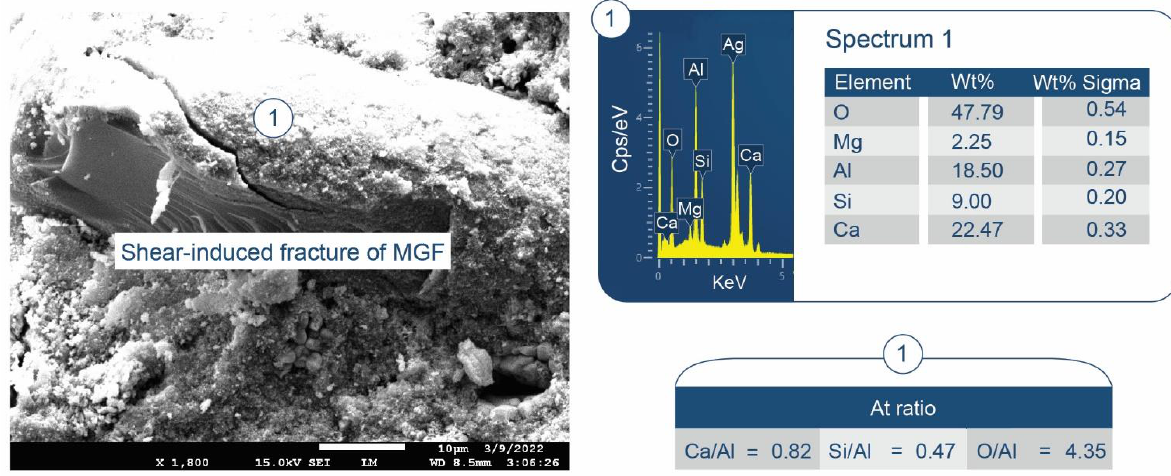
Figure 21. Photomicrograph of PR-changed MGF fiber of 250 °c-autoclaved Ca/MGF cement.